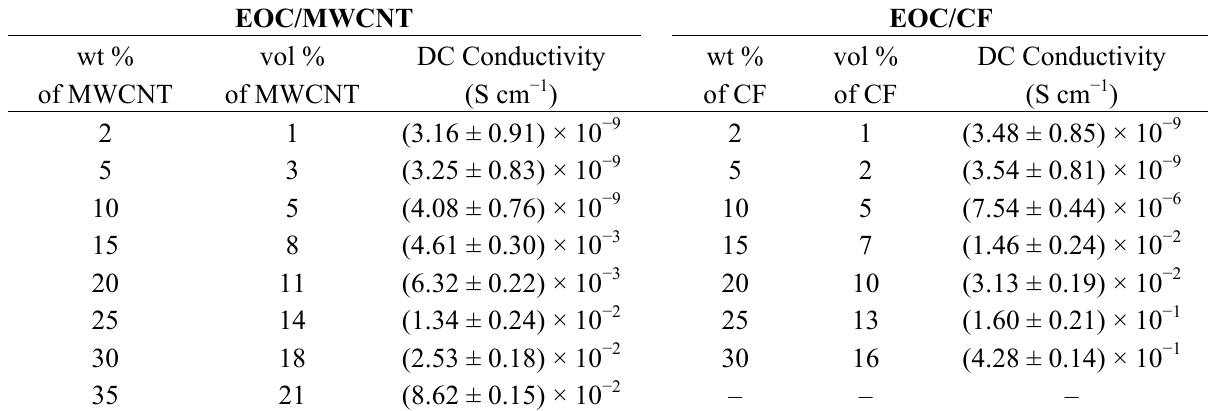
Table 1. DC electrical conductivity of the EOC composite samples containing multi-walled carbon nanotubes (MWCNT) or carbon fibers